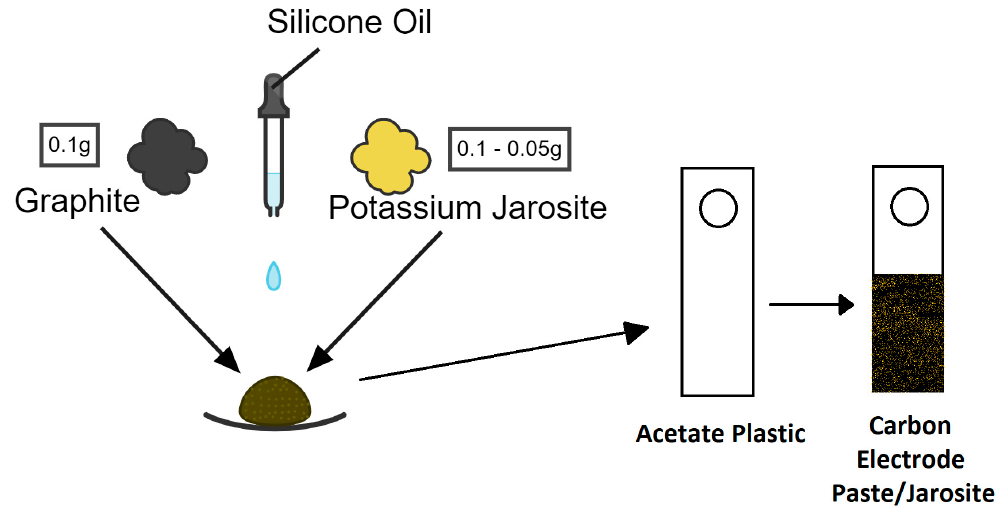
Figure 2. Elaboration of the electrodes for the evaluation of the electrical properties of jarosite.